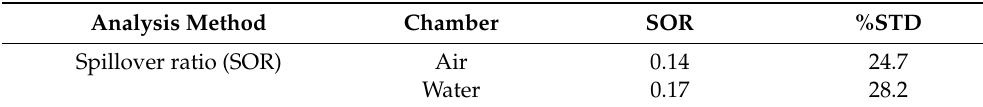
Comparing Bruker’s PET performance with other preclinical scanners, such as IRIS PET/CT [32], Inveon [30], FLEX Triumph X-PET (2D-FBP) [33], FLEX Triumph X-PET